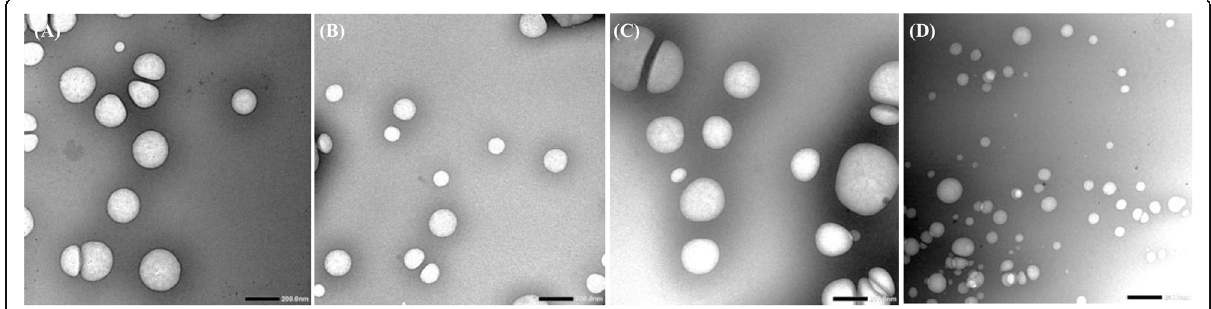
Fig. 3 Transmission electron micrograph of prepared pyrethroid nanoemulsions alpha-cypermethrin ( A ), deltamethrin ( B ), lambda-cyhalothrin ( C ) permethrin ( D ): The TEM was performed on a JEOL JEM-1400 Plus, transmission electron microscope operating at an acceleration voltage of 80.0 kV with a 20-mm aperture. Print magnification